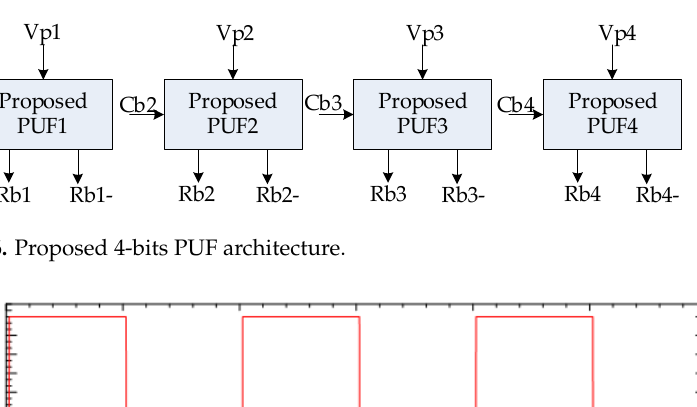
Figure 5. Evaluation result of challenge bit under the PMOS transistor body effect. PMOS bulk: tied to source (labeled as BS: body to source), tied to Vpc (labeled as Vpc) and tied to V dd (labeled as V dd ).